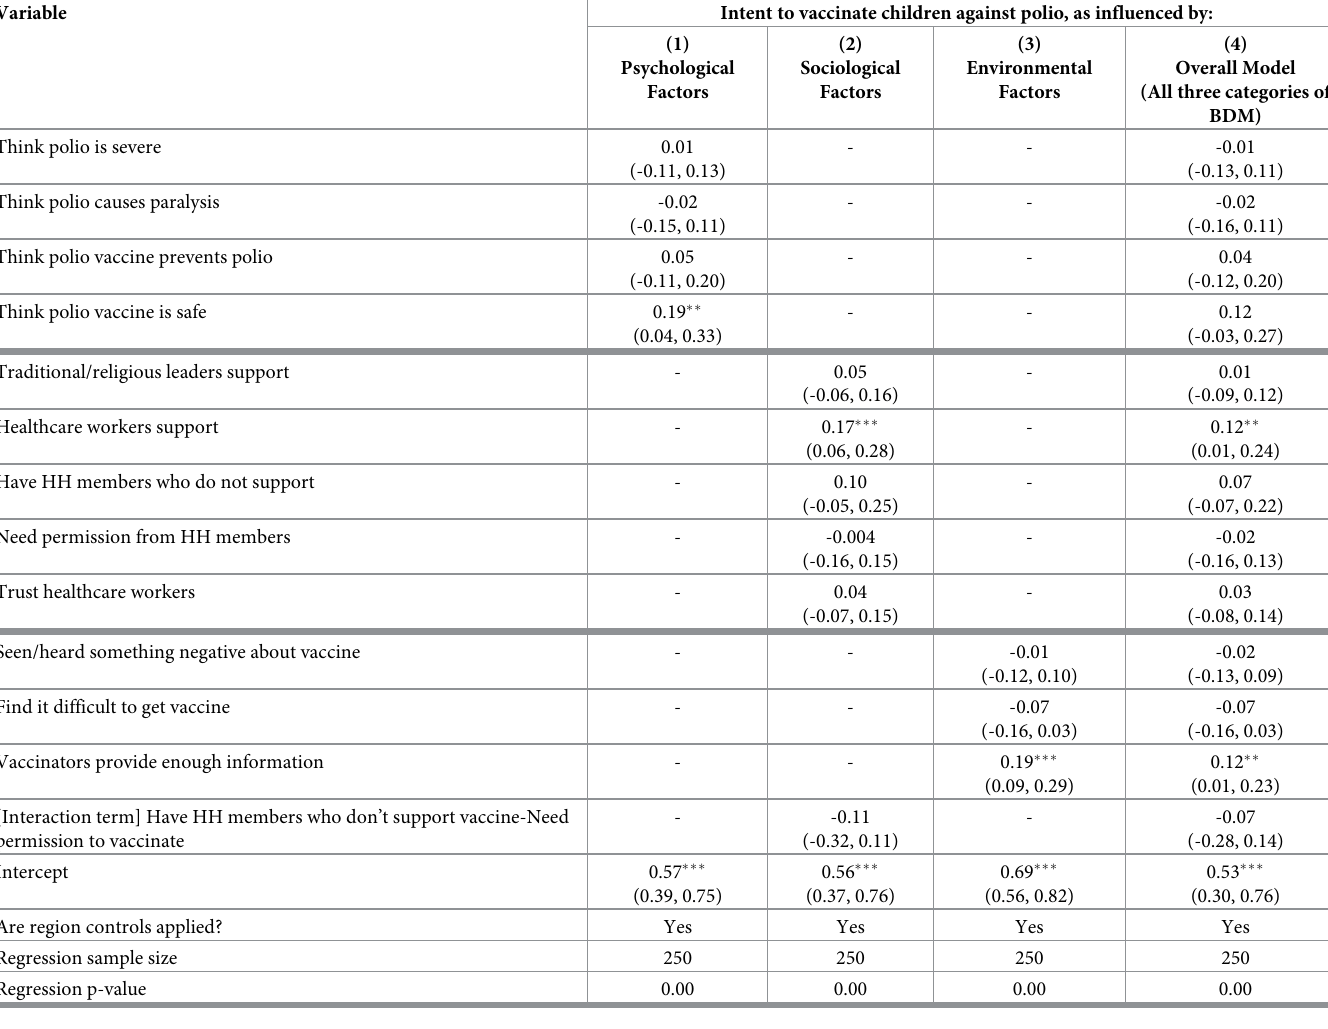
Table 4. Linear probability model on psychological, sociological, and environmental factors for intention to give polio vaccine to